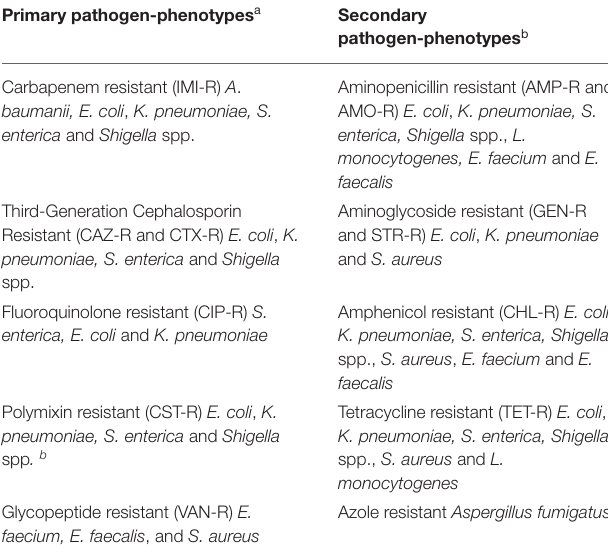
TABLE 2 | Pathogen-AMR phenotype combinations. Primary pathogen-phenotypes